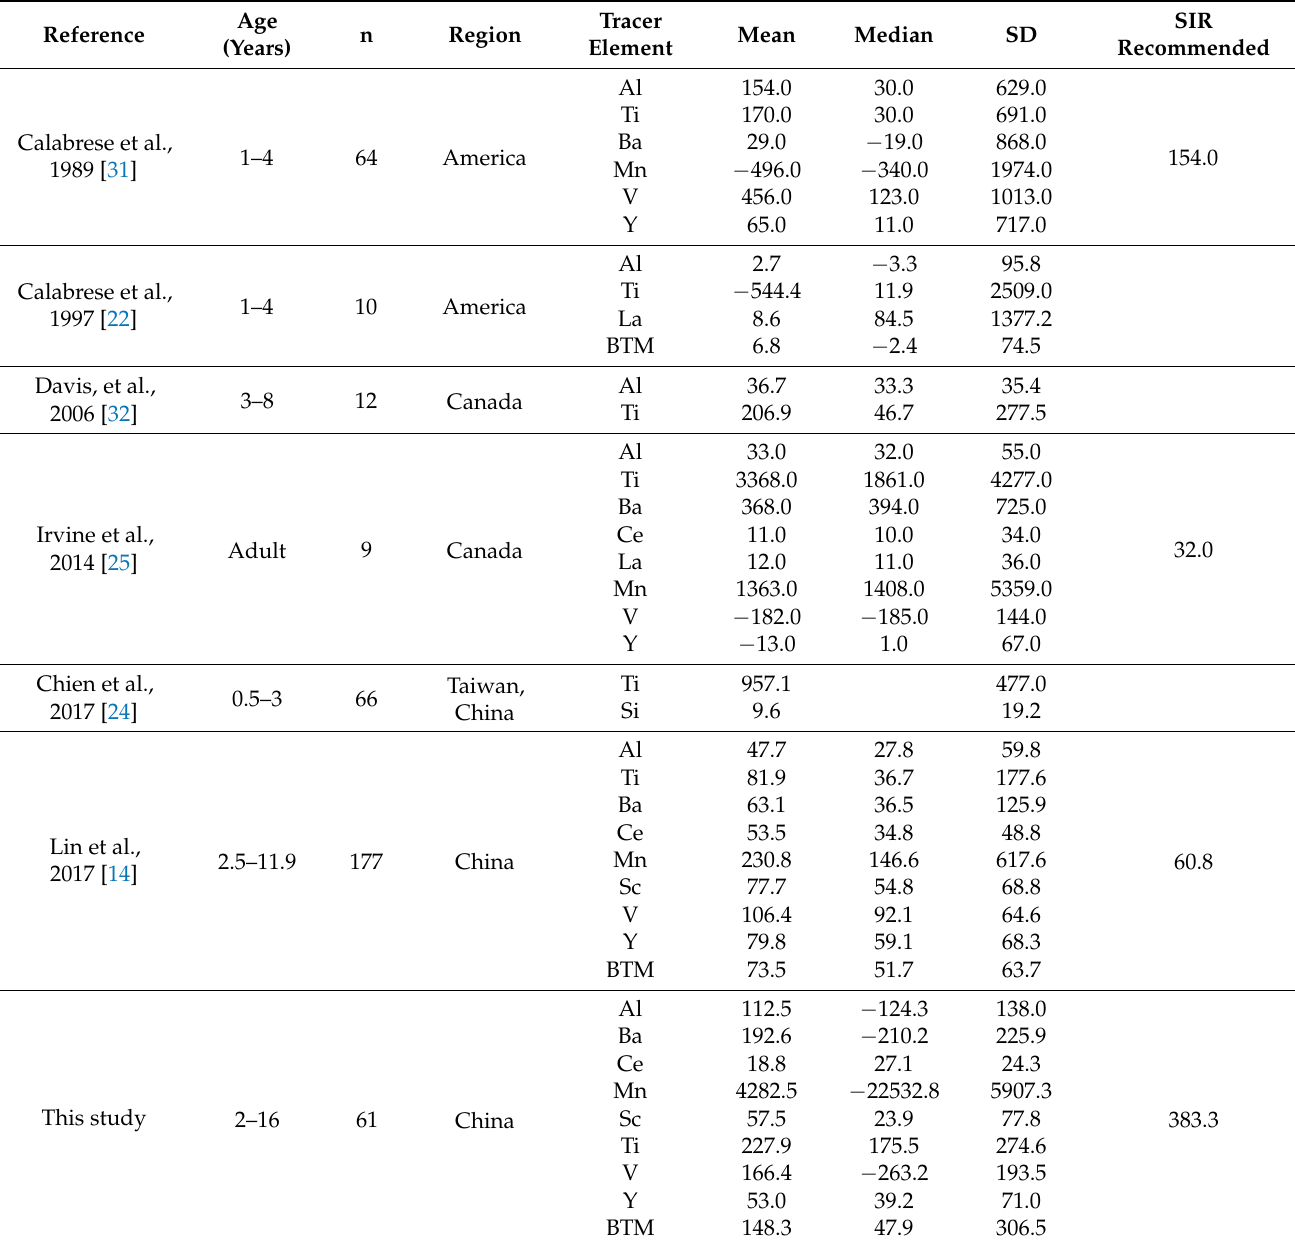
Table 2. SIR (mean, median, SD, and SIR recommended, mg/day) comparisons between published studies and this